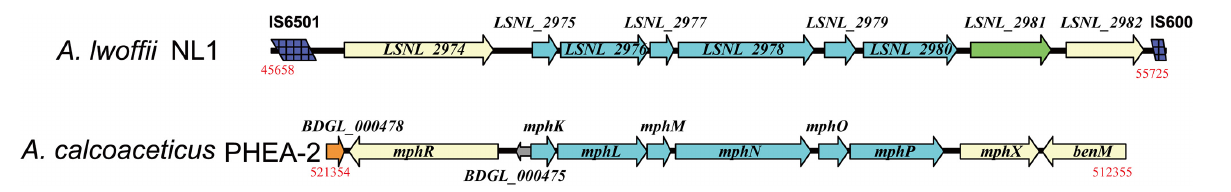
FIGURE 3 | Structures of phenol-degrading genes in A. lwoffii NL1 and A. calcoaceticus PHEA-2. The gene cluster LSNL_2973-2983 is located on megaplasmid pNL1 (between 45,658 and 55,725) in A. lwoffii NL1. The gene cluster BDGL_000467-000478 is positioned on the chromosome (between 512355 and 521354) of A. calcoaceticus PHEA-2. Cyan and green arrows represent genes for phenol hydroxylase and catechol 1,2-dioxygenase, respectively. Transcriptional regulators are present yellow arrows. BDGL_000475 and BDGL_000478 , respectively, encode hypothetical protein and copper chaperone in A. calcoaceticus PHEA-2. Putative transposases for insertion sequence elements are represented using quadrilateral meshes in A. lwoffii